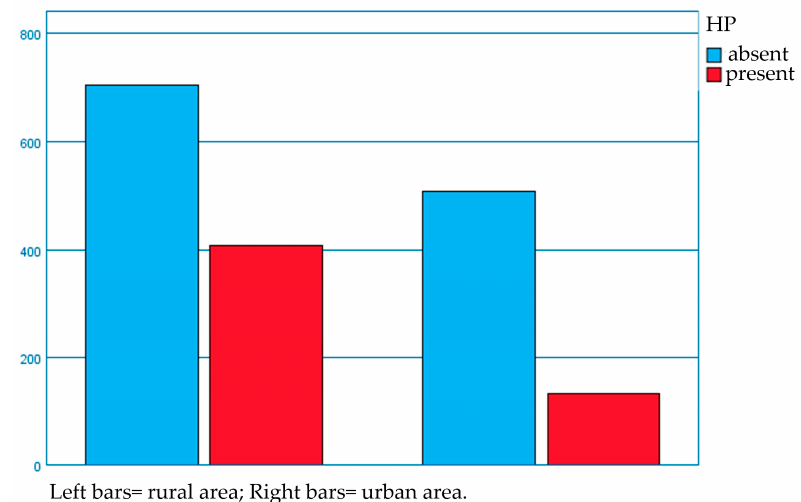
Figure 1. Environmental distribution of patients with or without infection with H. pylori .